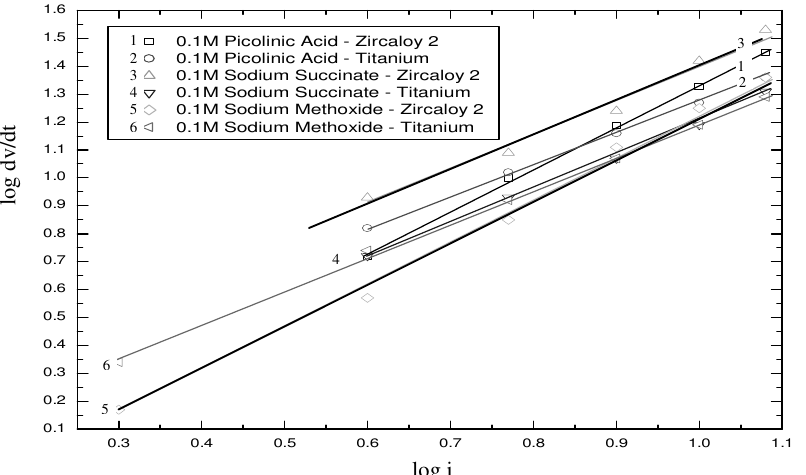
log Figure 1. Plots of logarithm of formation rate vs. logarithm of current density.